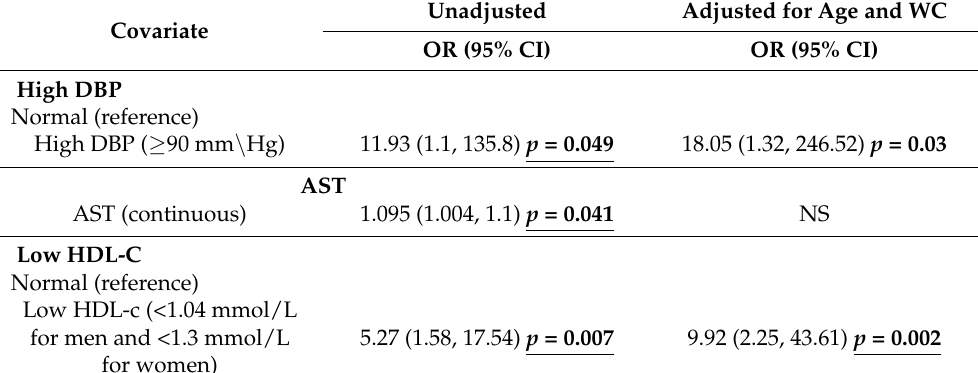
Table 3. Unadjusted and adjusted Odds Ratios (OR) with its 95% Confidence Interval (CI) for clinical and biochemical variables as predictors of NAFLD.